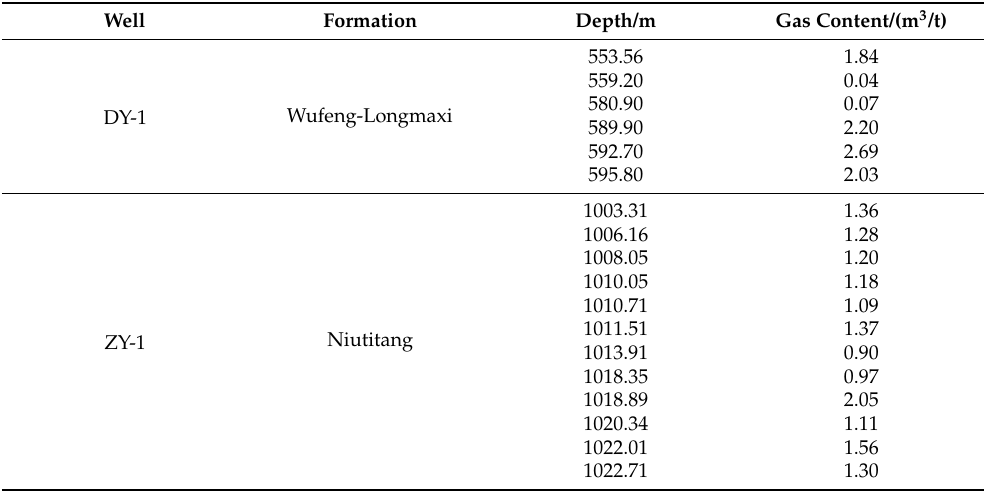
Table 7. The gas content of shale reservoirs in the Wufeng-Longmaxi and Niutitang Formations in northern Guizhou